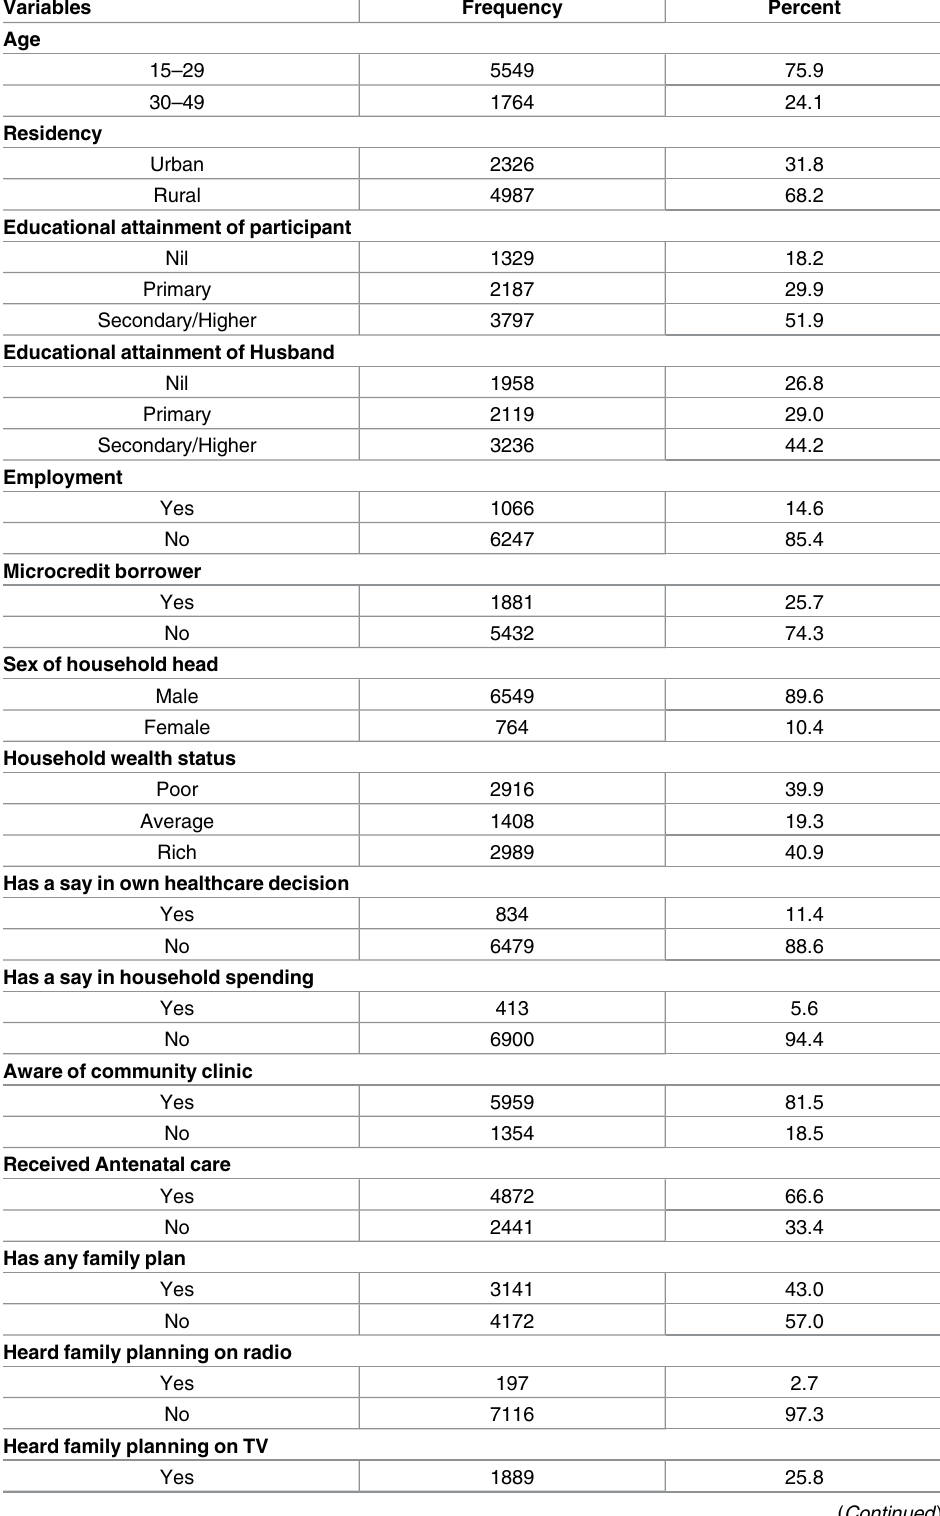
Table 1. Basic Socioeconomic and demographic characteristics of the study